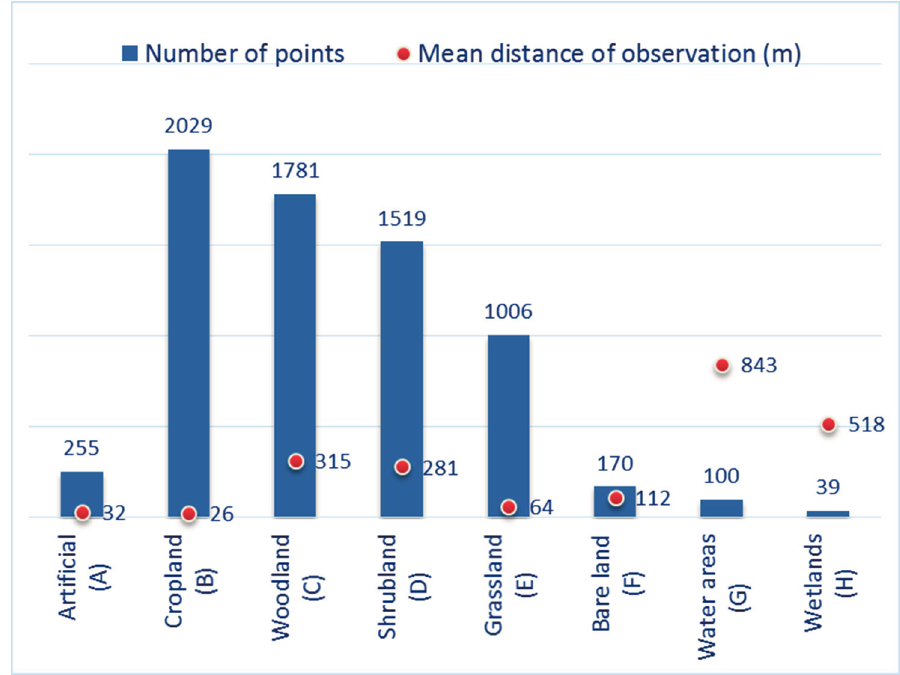
Figure 2. Distribution of the number of visited LUCAS 2009 points in Greece and their mean observation distance per major